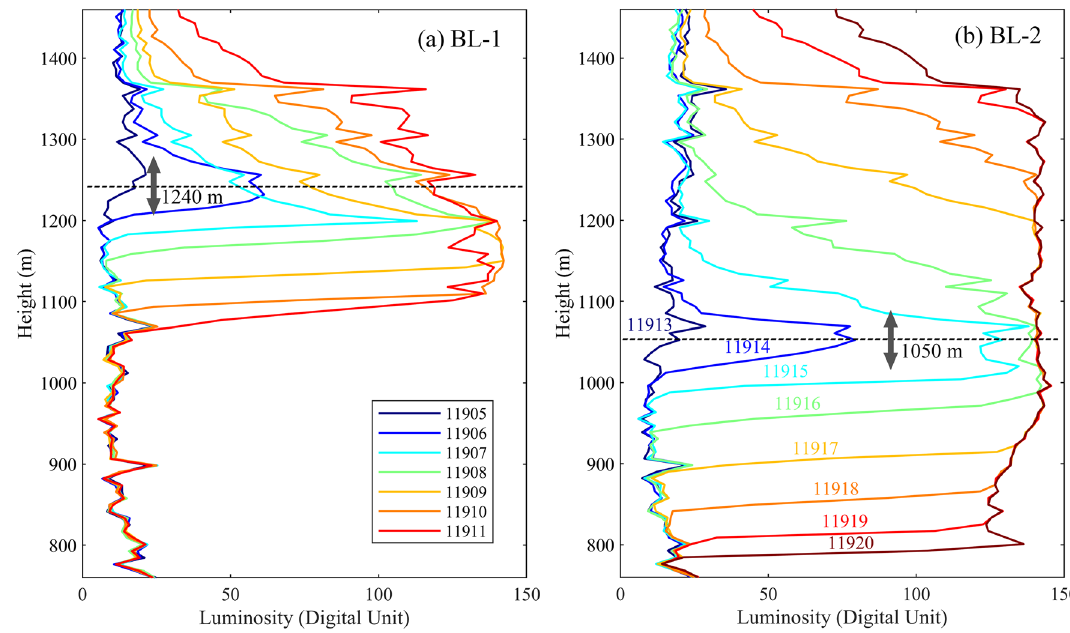
Figure 3. The maximum luminosity distributions of the bidirectional leader channel at different instants for the ( a ) BL-1 and the ( b ) BL-2 processes. The background noise has been removed. The legend in ( a ) and the labeled number in ( b ) corresponds to the frame number in Fig.